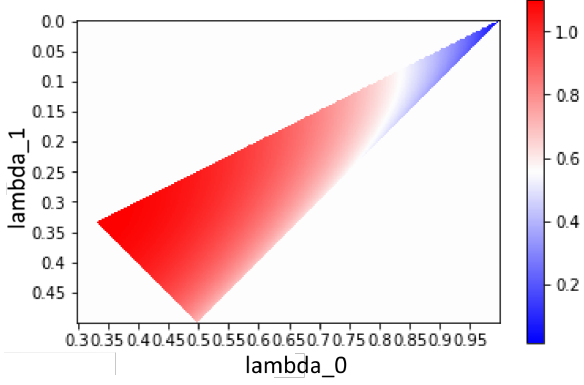
Figure 2. Eigenentropy as function of λ 0 and λ